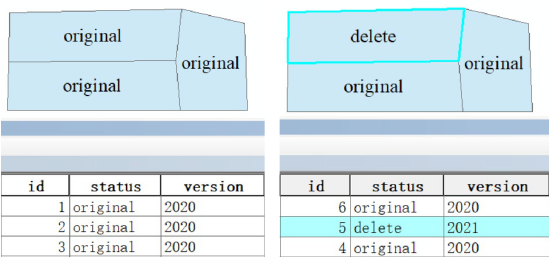
Figure 4 . Database fields information of deleted features